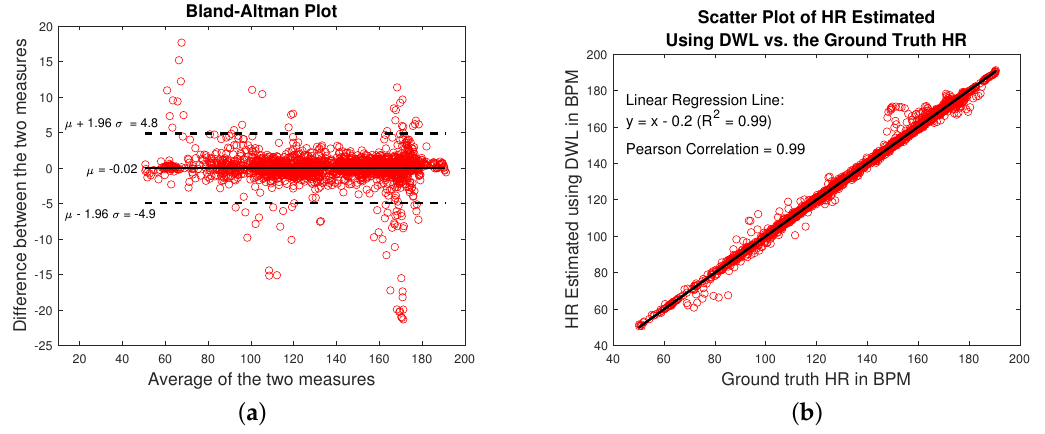
Scatter Plot of HR Estimated Using DWL vs. the Ground Truth HR